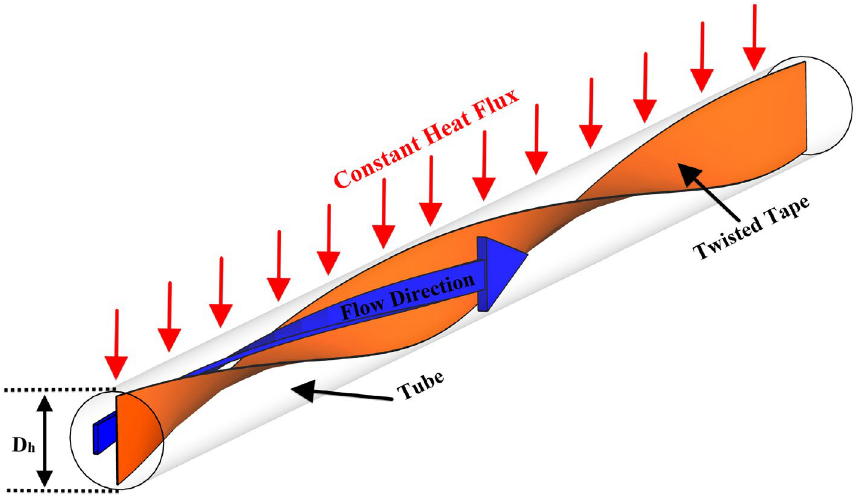
Figure 1. Schematic of the